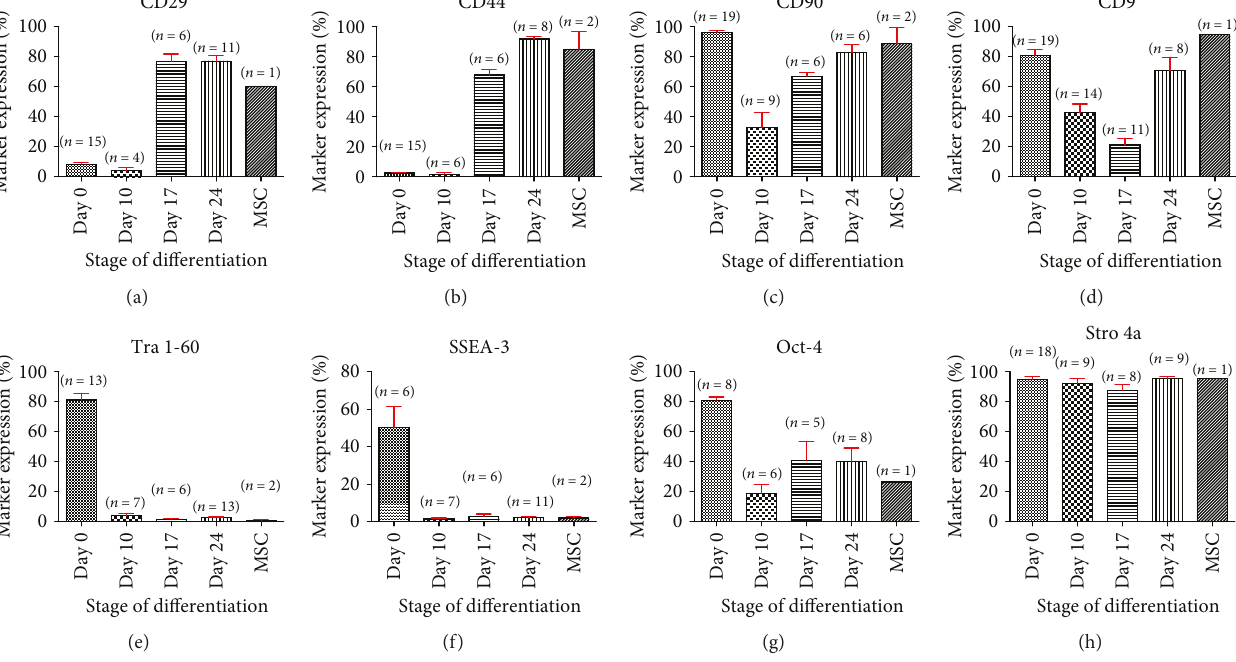
Figure 4: Average CD29 (a), CD44 (b), CD90 (c), CD9 (d), Tra 1-60 (e), SSEA-3 (f), Oct-4 (g), and HSP90 β (h) expression in BM-hMSCs and iPSC/ESC-derived MSCs before and during the mesengenic di ff erentiation process. The results suggest that both CD44 and CD29 lacked expression in undi ff erentiated cells and cells at MP0. The expression of these markers only increased to levels comparable to those of BM- hMSCs after the fi rst passage into MPC Growth MEM media. By MP2, the expression of CD44 increased again while the expression of CD29 remained at the same level. CD90, CD9, and HSP90 β , however, are highly expressed in both undi ff erentiated and mesenchymal stem cells derived from the bone marrow. HSP90 β remained strongly expressed during the entire mesengenic di ff erentiation process while the expression of CD90 and CD9 decreased after 10 days of exposure to SB431542 and increased again by MP1 and MP2, respectively. By MP2, the expression of CD90, CD9, and HSP90 β reached levels comparable to those of BM-hMSCs. Lastly, Tra 1-60, SSEA-3, and Oct-4 are only strongly expressed in undi ff erentiated cells while BM-derived MSCs and ESC/iPSC-derived MSCs lacked expression of these pluripotent stem cell markers. Both Tra 1-60 and SSE-3 remained poorly expressed during the entire mesengenic di ff erentiation process. On the other hand, the expression of Oct-4 decreased after 10 days of exposure to SB431542 and increased slightly after the fi rst passage in MPC Growth MEM media, remaining at this level on subsequent passages. By MP2, the expression of Tra 1-60, SSEA-3, and Oct-4 remained at levels comparable to those of BM-hMSCs. An average of the expression of these markers in all cell lines examined before and during the di ff erentiation process was combined to construct the